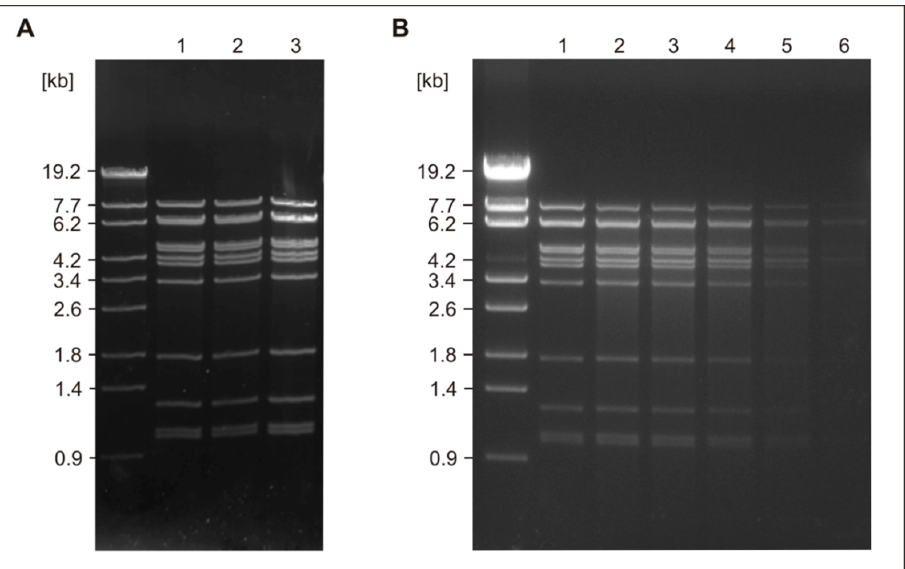
Figure 4. Determination of the DNA end structure of the phage genome. ( A ) Examination of cohesive ends; lane 1, lambda StyI marker, lane 2, EcoRV restriction pattern of untreated phage DNA, lane 2, EcoRV digest, heated at 80 °C and then chilled on ice, lane 3, EcoRV digest of T4-ligated phage DNA. ( B ) EcoRV restriction patterns of phage DNA previously treated by Bal31 for 0 (lane 1), 7.5 (lane 2), 15 (lane 3), 30 (lane 4), 60 (lane 5), and 120 min (lane